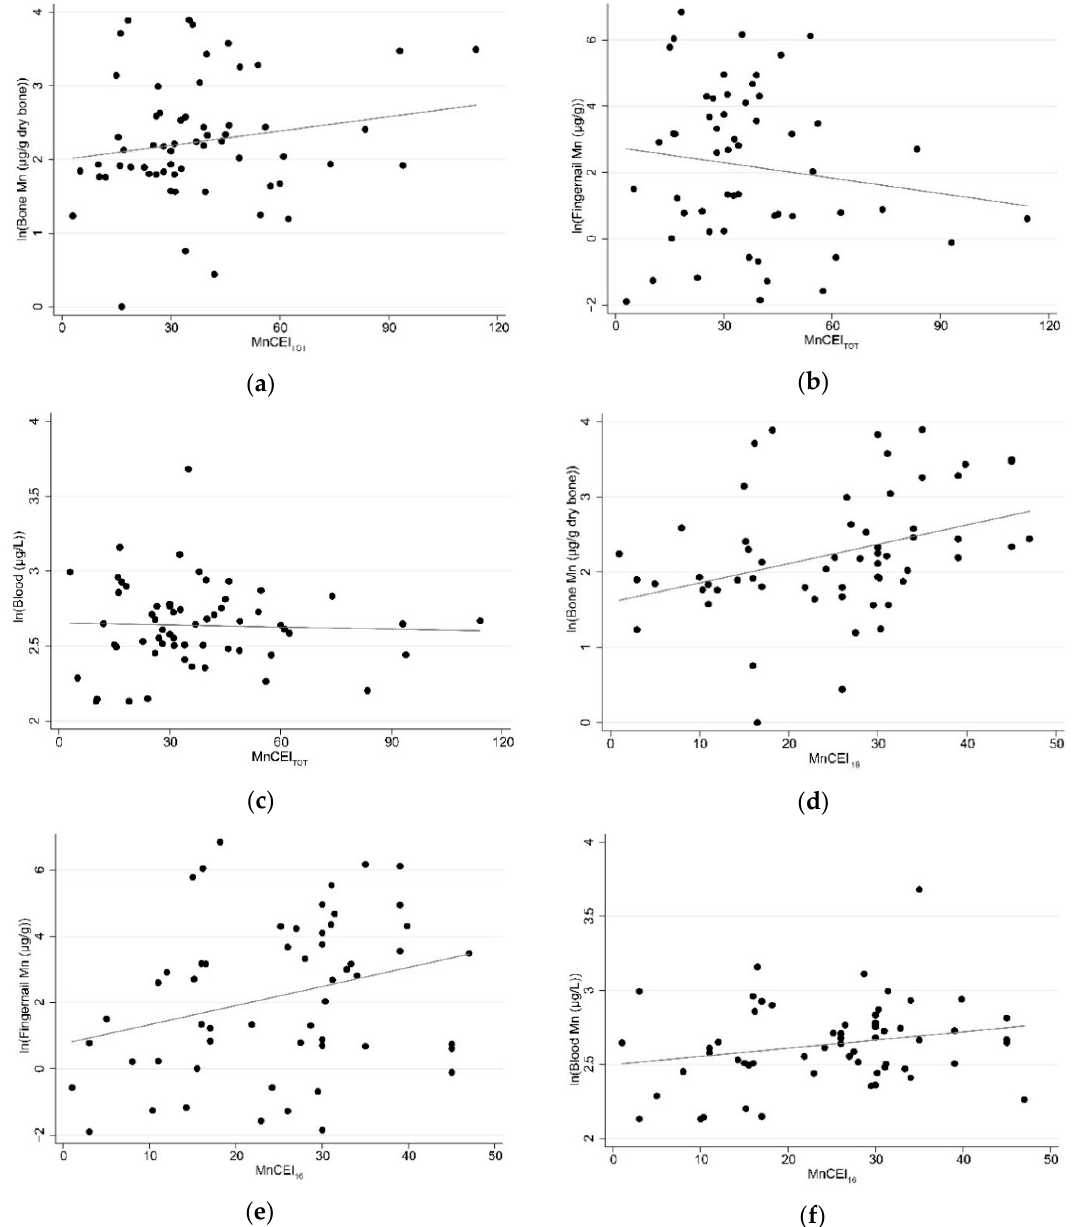
Figure 1. The scatterplots and unadjusted regression lines for ( a ) MnCEI TOT versus bone Mn; ( b ) MnCEI TOT versus fingernail Mn; ( c ) MnCEI TOT versus blood Mn; ( d ) MnCEI 16 versus bone Mn; ( e ) MnCEI 16 versus fingernail Mn; ( f ) MnCEI 16 versus blood Mn. Mn = manganese; MnCEI TOT = Manganese cumulative exposure index for lifetime work history; MnCEI 16 = Manganese cumulative exposure index since 2000.